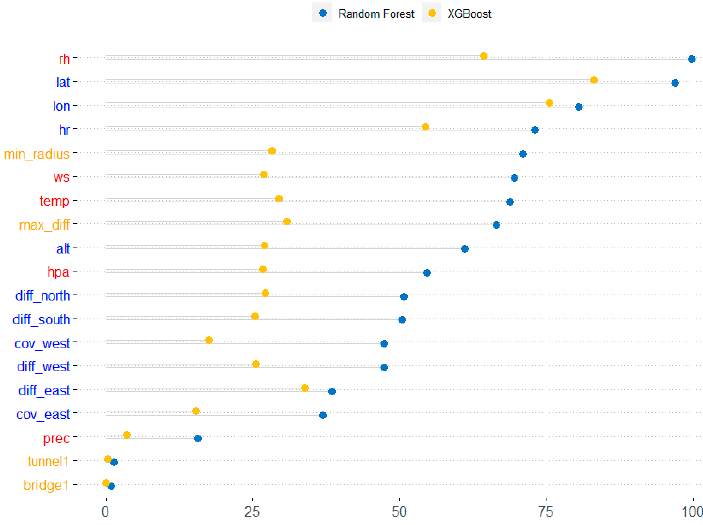
Figure 2. Important variables of Random Forest and XGBoost. Table 4. The summary of logistic regression